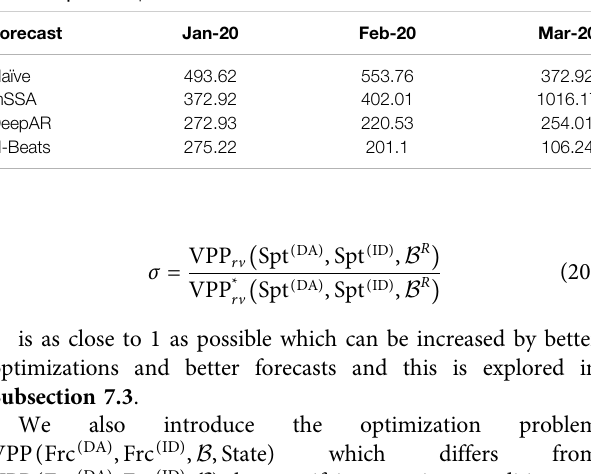
TABLE 2 | Mean squared